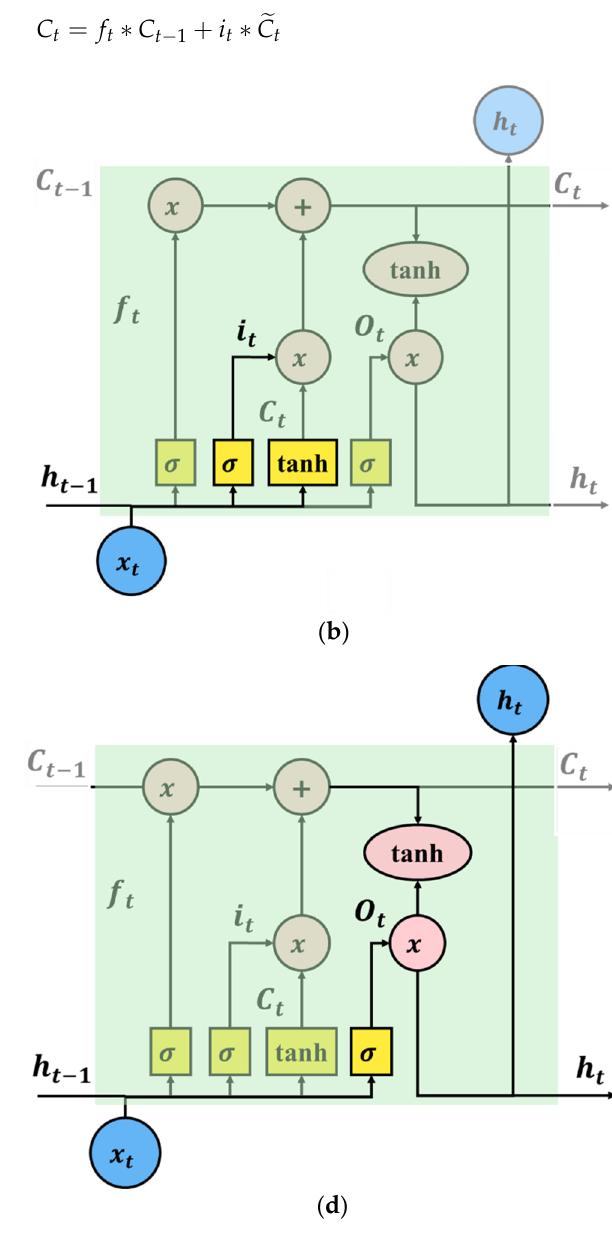
Figure 3. The LSTM internal structures: ( a ) the forgetting gate structure; ( b ) signal acquisition in the input gate; ( c ) obtaining 𝐶 (cid:3047) in the input gate; ( d ) the output gate structure [27].